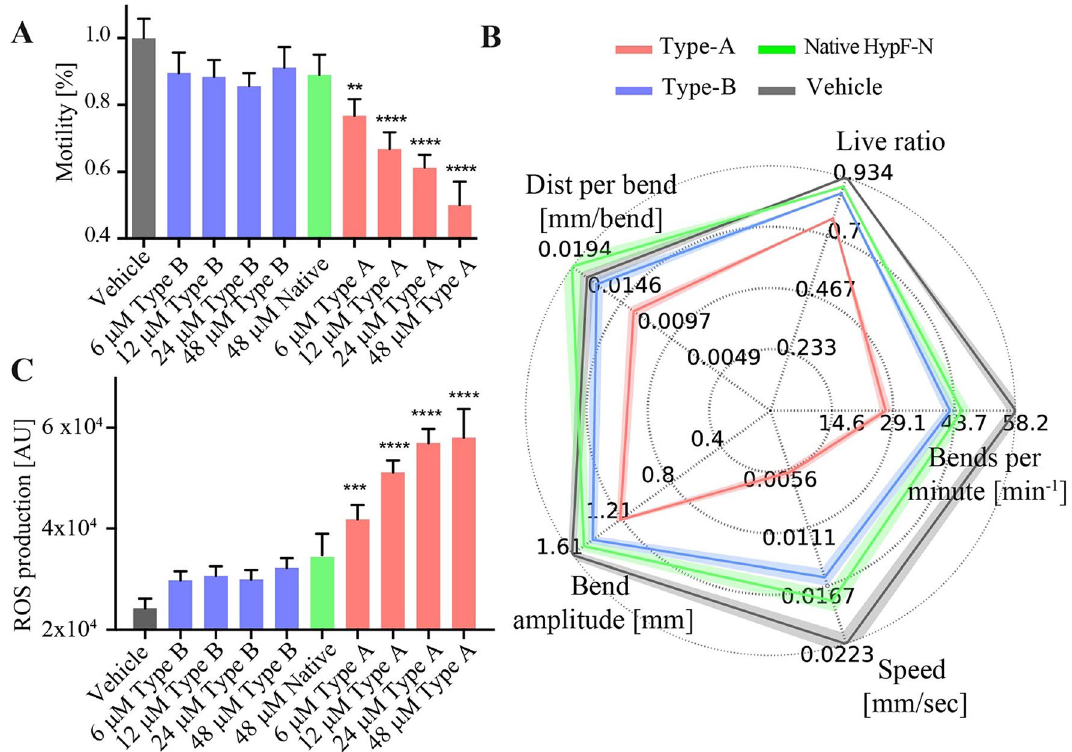
Figure 2. Effects of early exposure to HypF-N oligomers on worm fitness. ( A) Type A (red) and type B (blue) oligomers of HypF-N 27 , at 6, 12, 24, 48 μM and native HypF-N at 48 μM (green) were administered to C. elegans at day 0 (D0). 600 animals were analyzed in each experiment, and a representative of three replicas, which showed similar results, is shown. Statistical tests (Student’s t test) were carried out using Graph-pad prism. All tests have been two tailed unless stated otherwise. Error bars indicate the standard error of the mean (SEM). The double (**), triple (***) and quadruple (****) asterisks indicate P ≤ 0.01, 0.001 and 0.0001, respectively, relative to unexposed worms. ( B ) High resolution phenotypical fingerprinting carried out using WF-NTP. Multiple fitness readouts (speed, bends per minute, bend magnitude, distance per bend and live ratio) are reported. Up to 1200 animals per condition were analyzed. Thick colored lines indicate the mean and SEM values. ( C ) ROS production in worms exposed at D0 with type A (red) and type B (blue) oligomers of HypF-N 27 , at 6, 12, 24, 48 μM and native HypF-N at 48 μM (green) Bars indicate the means and SEM